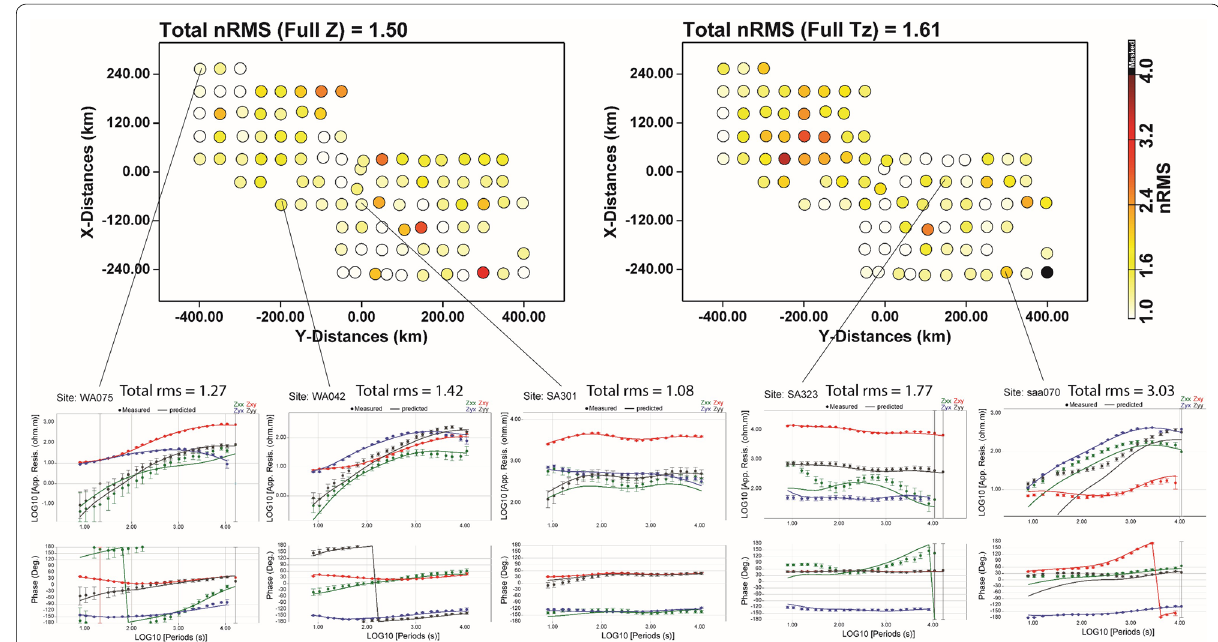
Fig. 5 Model Fit plots for all sites in the Musgrave Province. The final RMS for the preferred 3D inverse model is 1.53 (Z RMS Within the Musgrave Province, data are generally flat, with strong resistivity splits between modes (e.g. SA301, SA323). Note the out of quadrant phase in the southeast part of the grid near the north-western edge of the Gawler Craton (Site